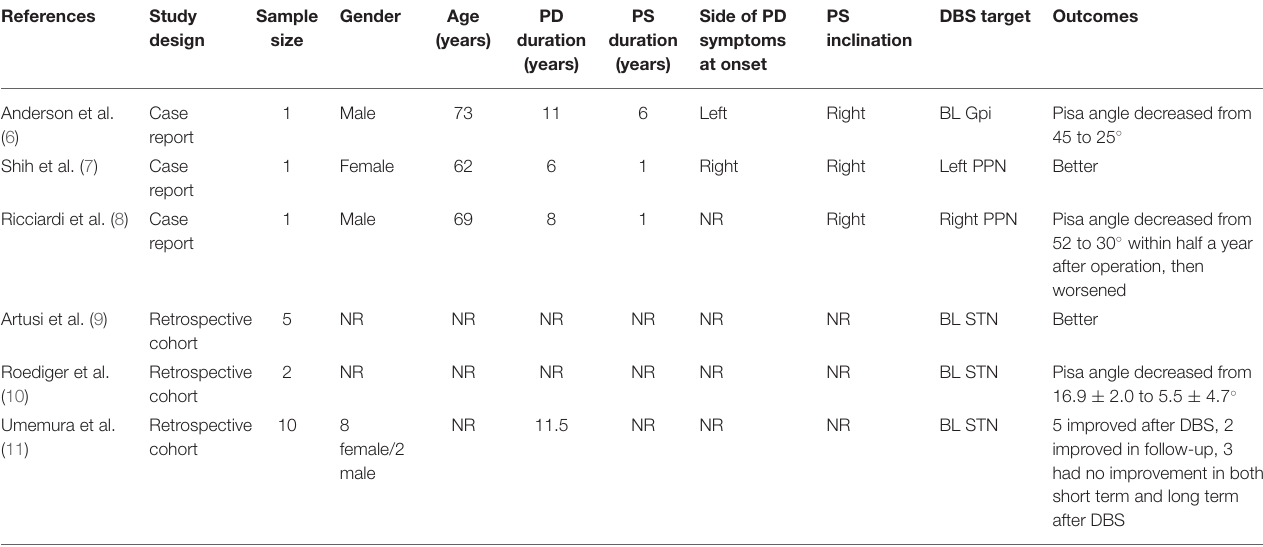
TABLE 2 | Summary of studies for patients with parkinsonian Pisa syndrome treated with